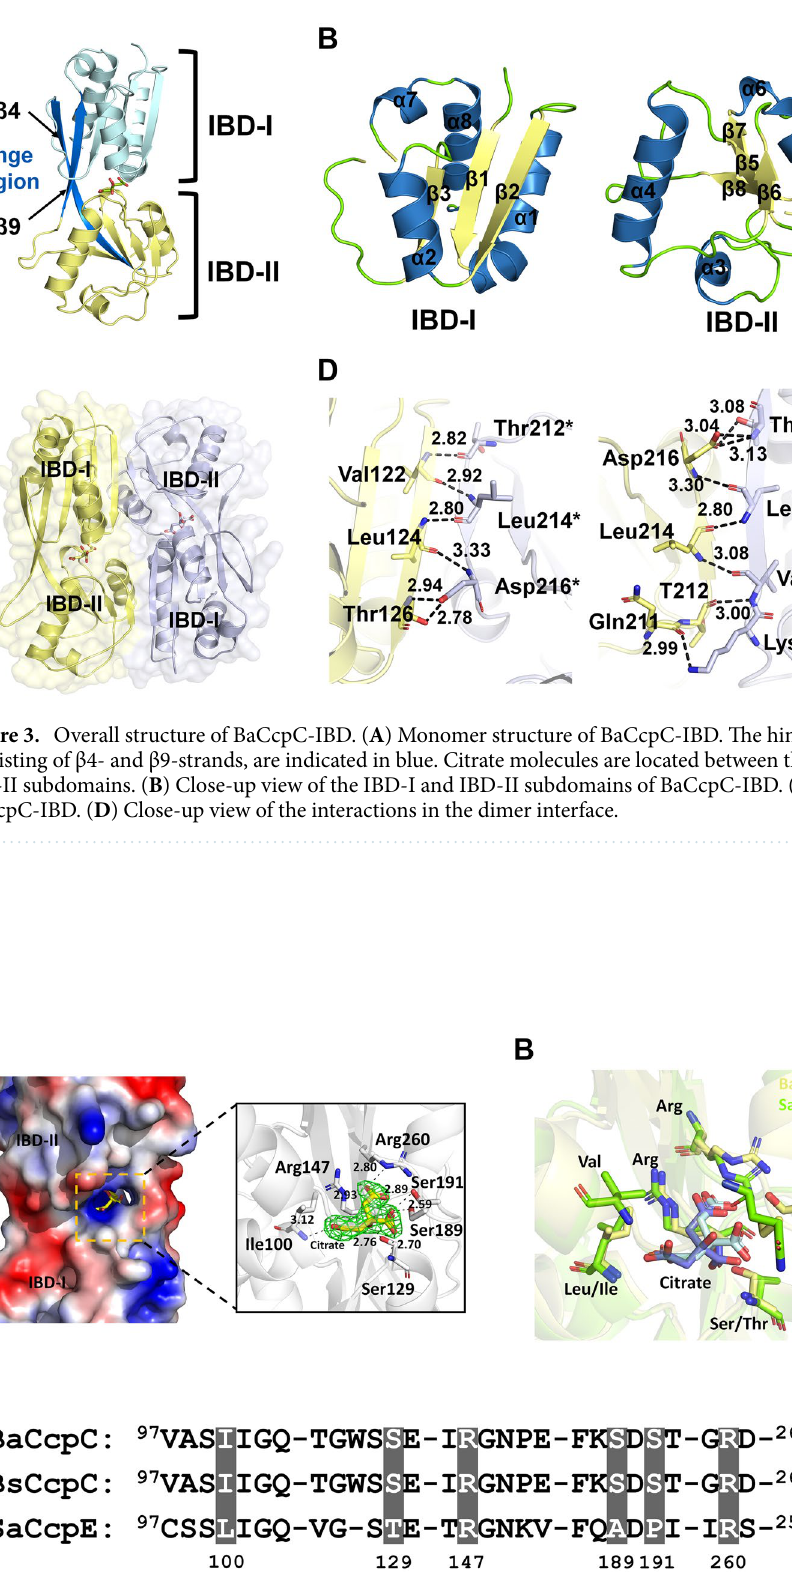
Figure 4. Citrate binding site of BaCcpC-IBD. ( A ) Citrate binding to the interface between IBD-I and II of BaCcpC-IBD. (Insert) Interaction between citrate and BaCcpC-IBD. Simulated annealing 2mFo-DFc omit electron (green mesh, 1σ) density map for citrate molecules. ( B ) Partial sequence alignment of the citrate binding sites of BaCcpC, BsCcpC, and SaCcpE. ( C ) Superimposition of the citrate binding sites of the IBD of BaCcpC (yellow) and SaCcpC